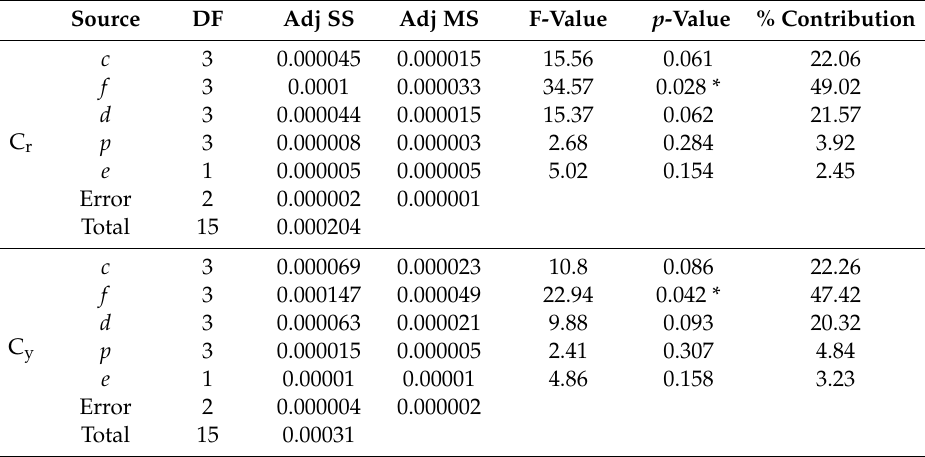
Table 4. Analysis of variance for circularity and cylindricity deviations.